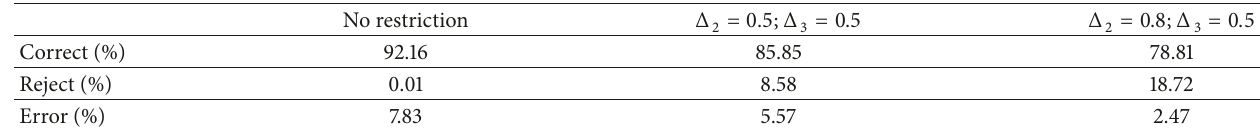
Figure 4: Subjectivity detection using HMM. Table 3: Cross validation results of ANFIS with TF ⋅ ICF feature.